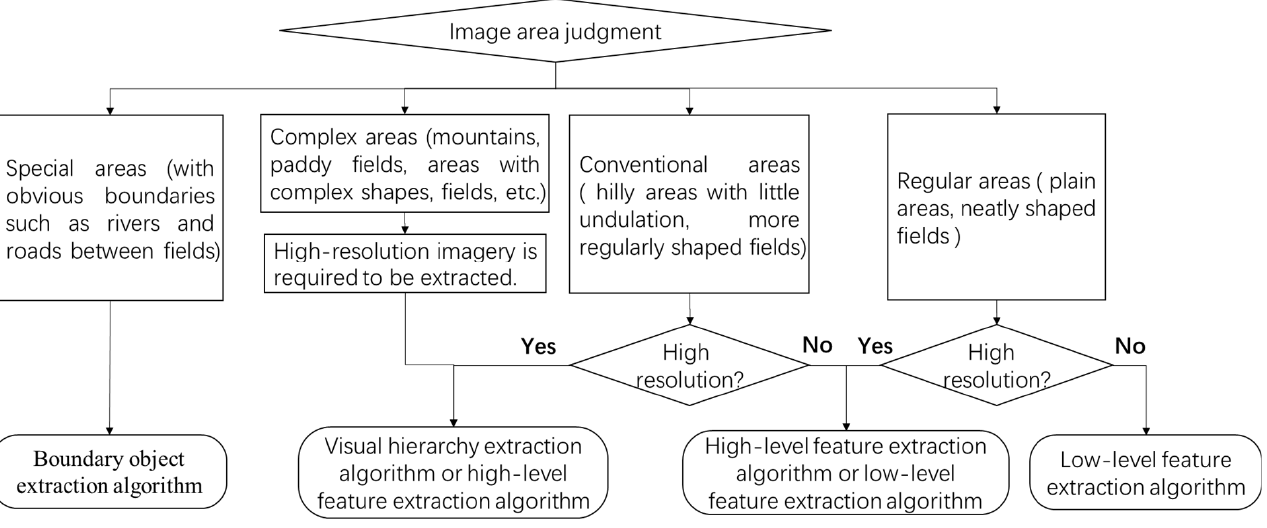
Figure 5. Flowchart of algorithm selection.